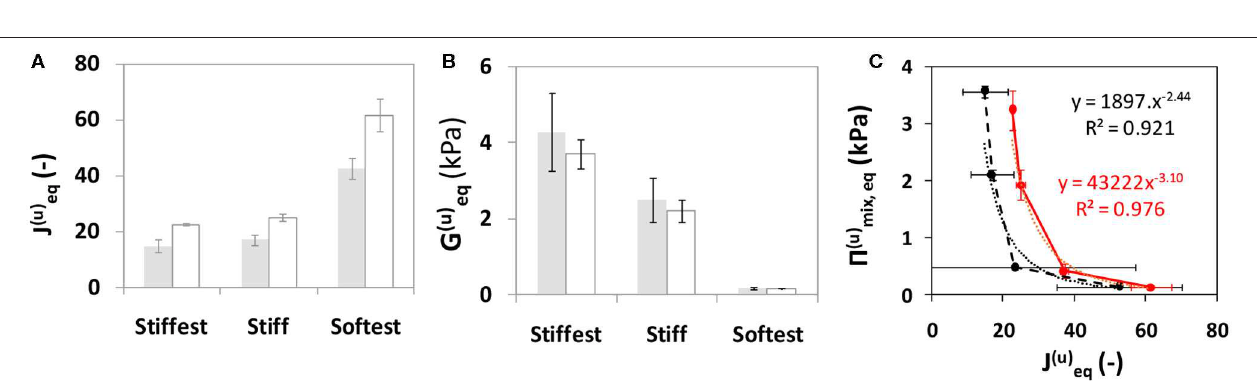
FIGURE 4 | Measured swelling ratio of substrate-attached gels as a function of swelling time: (A) long term swelling experiments (up to 6 days) for four different hydrogel compositions (whiskers indicate SD); (B) short term swelling experiments (up to 24h) for soft and softest hydrogels (whiskers indicate SD).